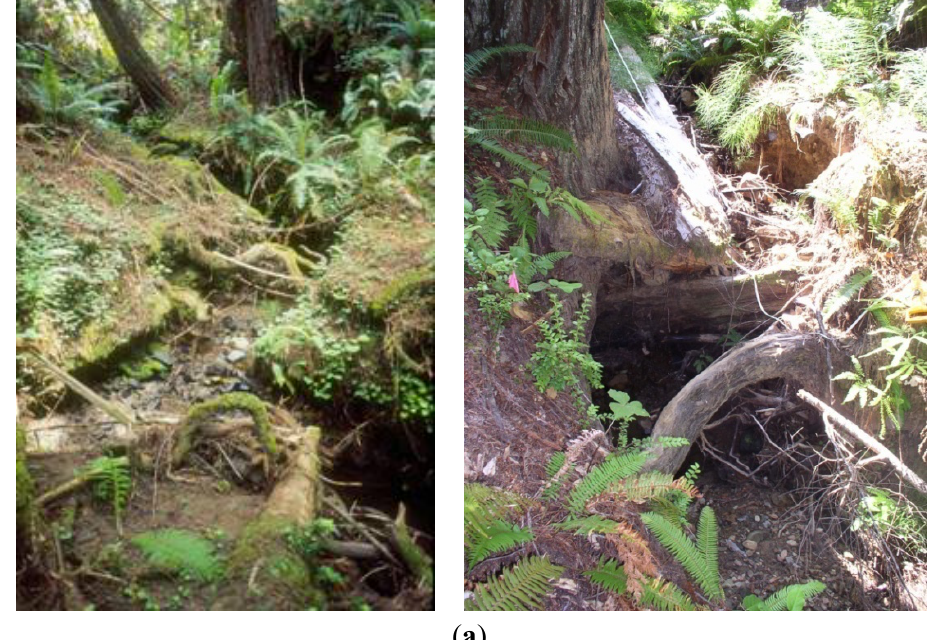
Figure 4. ( a ) Head-cutting and channel incisement immediately downstream of the harvest (Figure 3) on tributaries of North Fork Caspar Creek. Note newly exposed tree roots. Photos by S. Hilton; ( b ) Map of head-cutting and channel incisement (red dots) on class II tributaries of North Fork Caspar Creek post-harvest (Adapted from Dewey